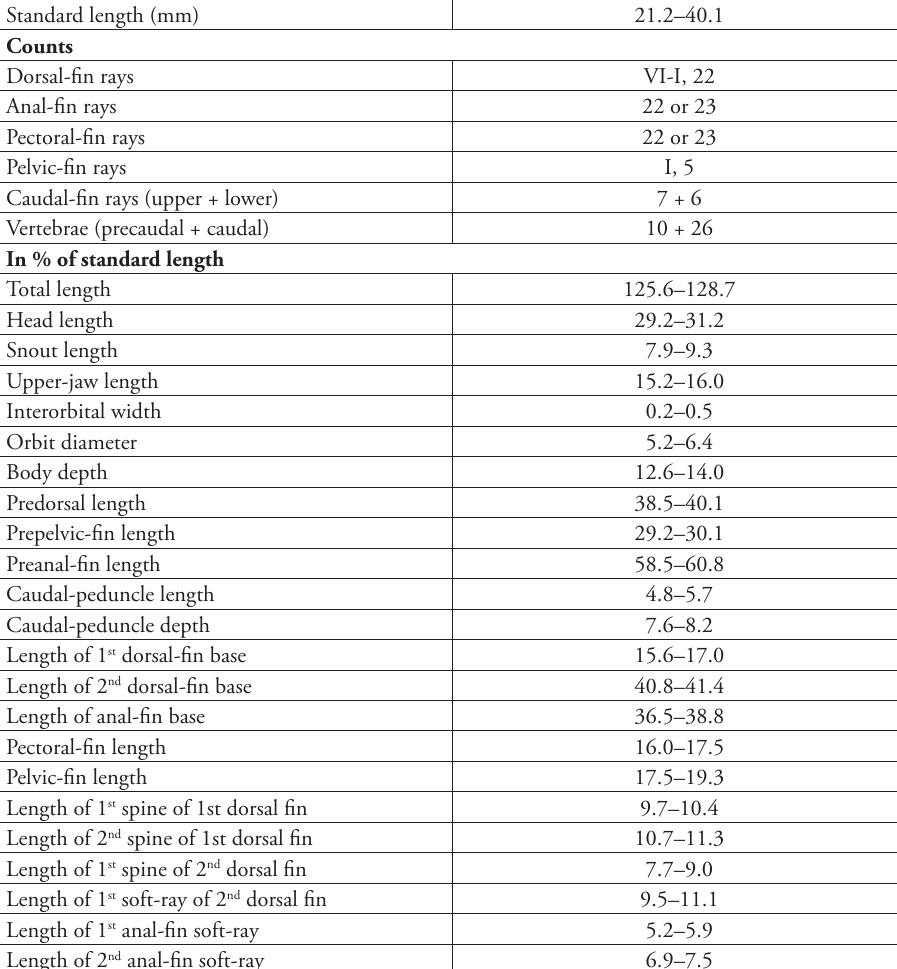
Table 1. Counts and proportional measurements of Apocryptodon punctatus ( n = 5) from Kushima City, Miyazaki Prefecture, Kyushu, southern